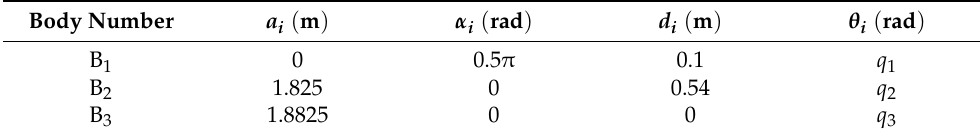
Table 2. Denavit-Hartenberg parameters of the